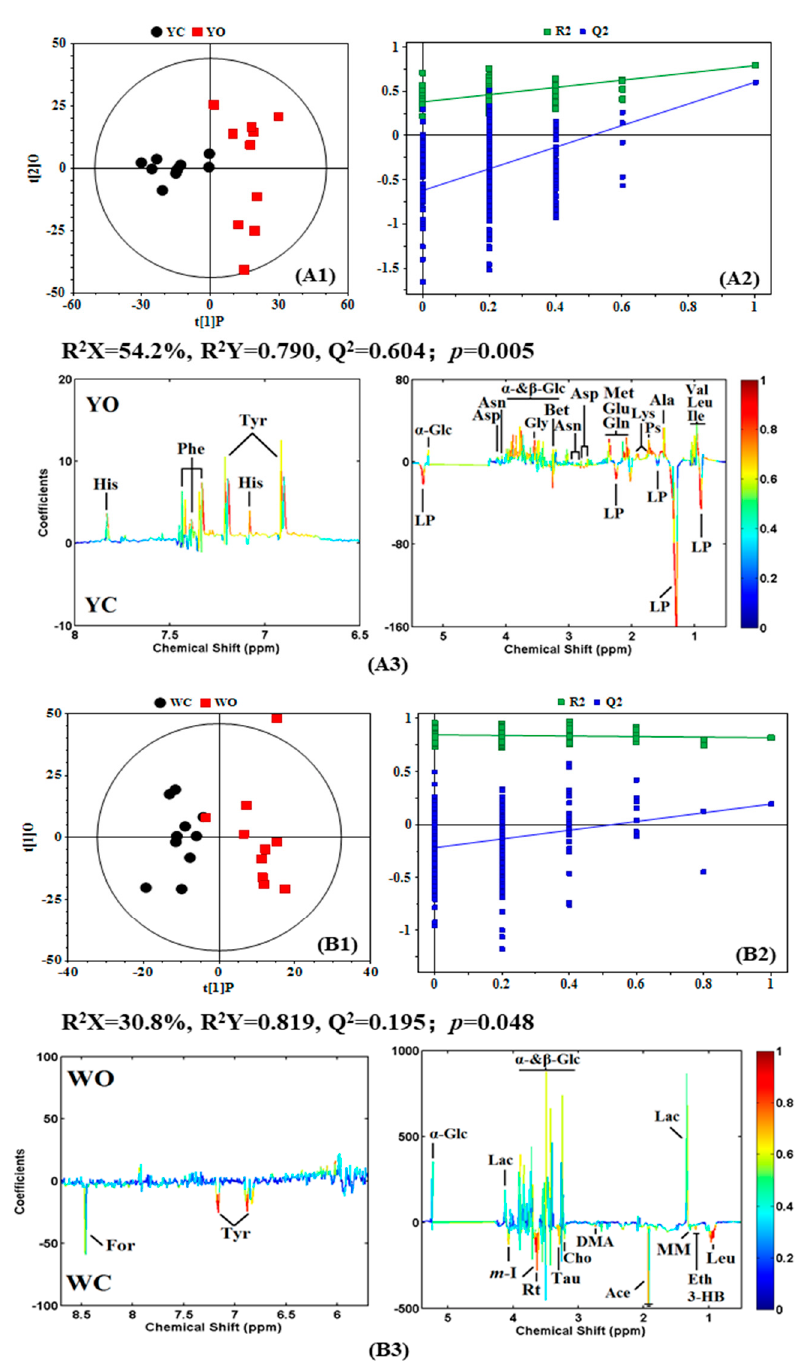
Figure 3. Orthogonal partial least square (OPLS-DA) scores plots ( 1 ), permutation tests (n = 200) ( 2 ) and corresponding coefficient loading plots ( 3 ) derived from 1 H NMR spectra of egg yolk ( A ) and egg white ( B ) obtained from conventional and organic eggs. YC: egg yolk from conventional eggs; YO: egg yolk from organic eggs; WC: egg white from conventional eggs; WO: egg white from organic eggs. R 2 X and R 2 Y represent the cumulative interpretation rate in the x-axis and y-axis directions, respectively. Q 2 represents the cumulative prediction rate of the model. The color map shows the significance of nutritional components variations between conventional and organic eggs. Peaks in the positive direction indicate the nutritional components that are more abundant in the organic eggs. Consequently, the nutritional components that are more abundant in the conventional eggs are presented as peaks in the negative direction. Keys of the assignments were shown in Figure 1.